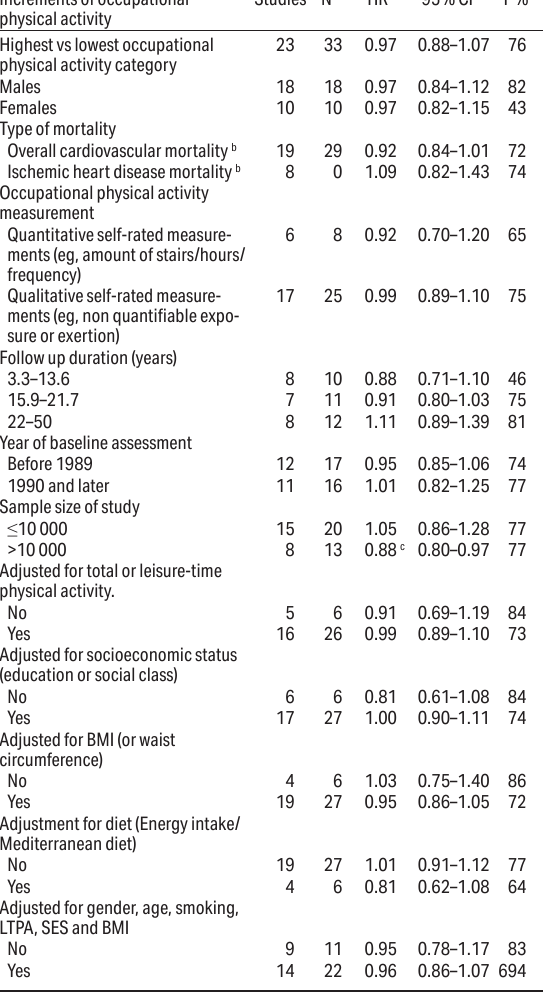
Table 1. Meta-analyses depicting the association between occupa- tional physical activity (highest versus lowest) and cardiovascular dis- ease mortality. Comparisons from 23 studies with 655 892 participants are depicted in the upper row. Associations are shown stratified by gender, type of mortality, occupational physical activity measurement, follow-up period, year of baseline assessment, sample size of study, adjusting for confounders. [HR=hazard ratio; CI=confidence interval;